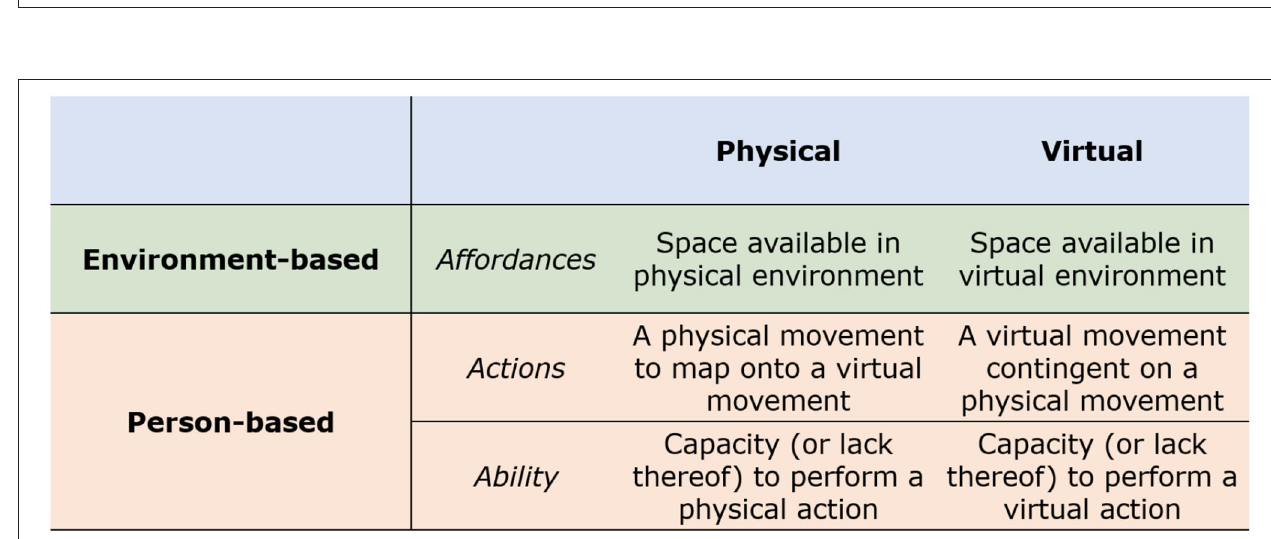
FIGURE 2 | Typology of Protean kinematics, which refers to the intersection of physical affordances/actions and virtual affordances/actions. Here, we depict affordances as space, physical actions as human actions, and virtual actions as avatar actions.